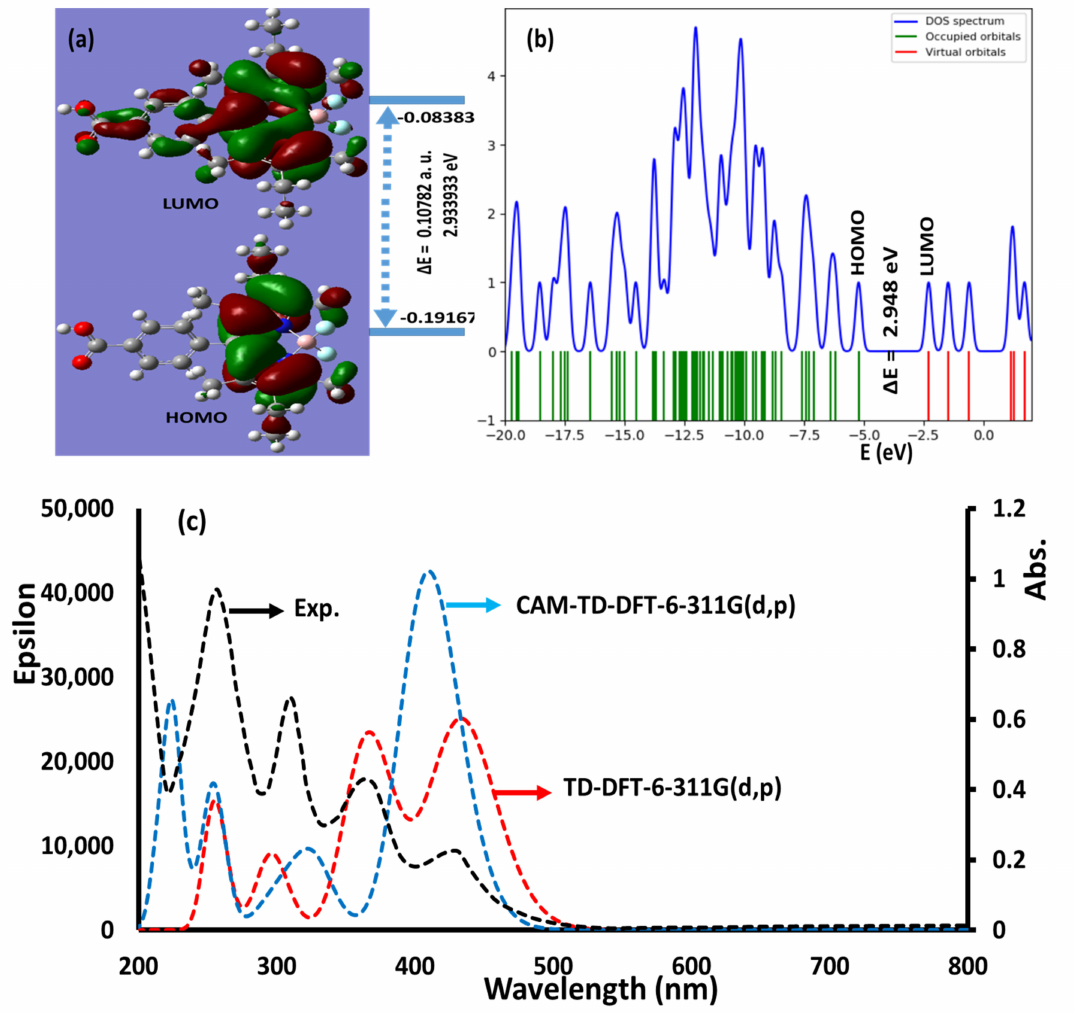
Figure 8. ( a ) HOMO/LUMO, ( b ) DOS, and ( c ) experimental, TD-DFT, and CAM-TD-DFT spectra in MeOH. The experimental and TD-DFT solvents’ effect on the electron transition in [N ∩ NBF 2 ] was evaluated as seen in Figure 9. Due to the poor solubility of the complex, the study was limited to DMSO, CH 3 CN, CHCl 3 , and MeOH solvents. Experimentally, no changes on the wavelengths but only a slight change in the intensity of the four packs were detected by changing the solvents, as can be seen in Figure 9. In the TD-DFT, only the two internal peaks have slight changes on the wavelengths and the intensity of the band; the terminal peaks have no effect by changing the solvents, as seen in Figure